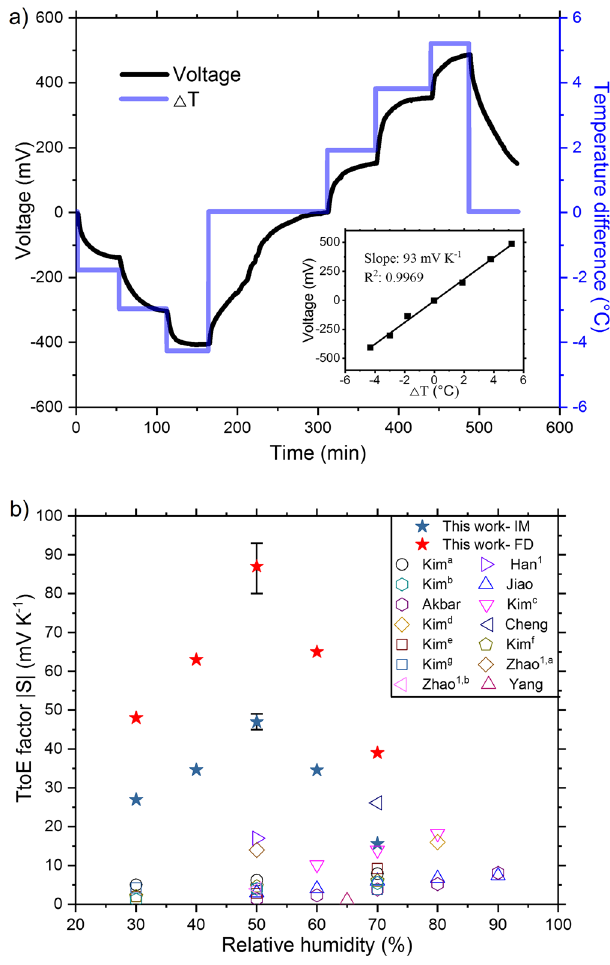
Fig. 2 Thermal-to-electrical conversion factor. a An exemplary voltage pro fi le of the device with the fully developed oxidation layer under 50% RH as a function of time when the temperature difference ( Δ T) was altered. The inset shows the saturated voltage at the corresponding temperature to seek the slope (93 mV K − 1 ). Note that the TtoE factor has the opposite sign ( − 93 mV K − 1 ) like conventional thermopower. b TtoE factors (absolute value) of our devices with the intermediate (IM) and fully developed (FD) oxidation layers along with data in the literature, Kim [a 9 , Han 15 , Kim [b 12 , Jiao 13 , Akbar 10 , Kim [c 14 , Kim [d 24 , Cheng 32 , Kim [e 11 , Kim [f 11 , Kim [g 12 , Zhao [a 33 , Zhao [b 33 , and Yang 34 . Error bar: one standard deviation. 1 RH is assumed to be